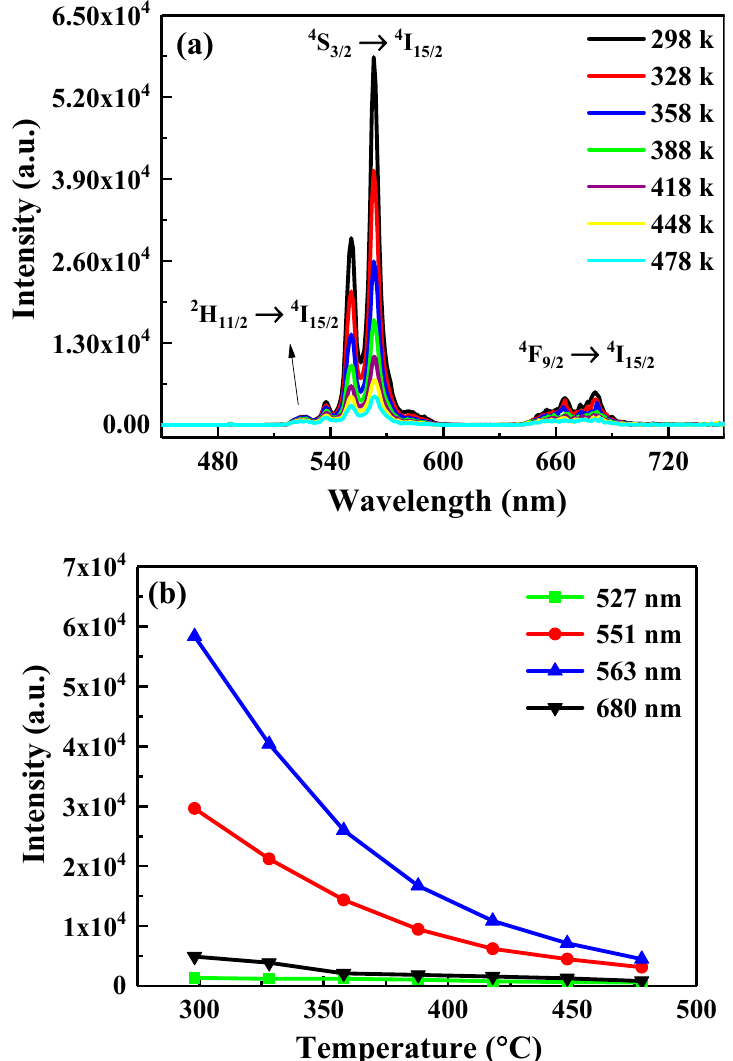
Figure 5. ( a ) Upconversion photoluminescence (UL PL) ( λ ex = 980 nm) spectra of the crystals at different temperatures. ( b ) The dependence of luminescence intensity on temperature located at different wavelengths.